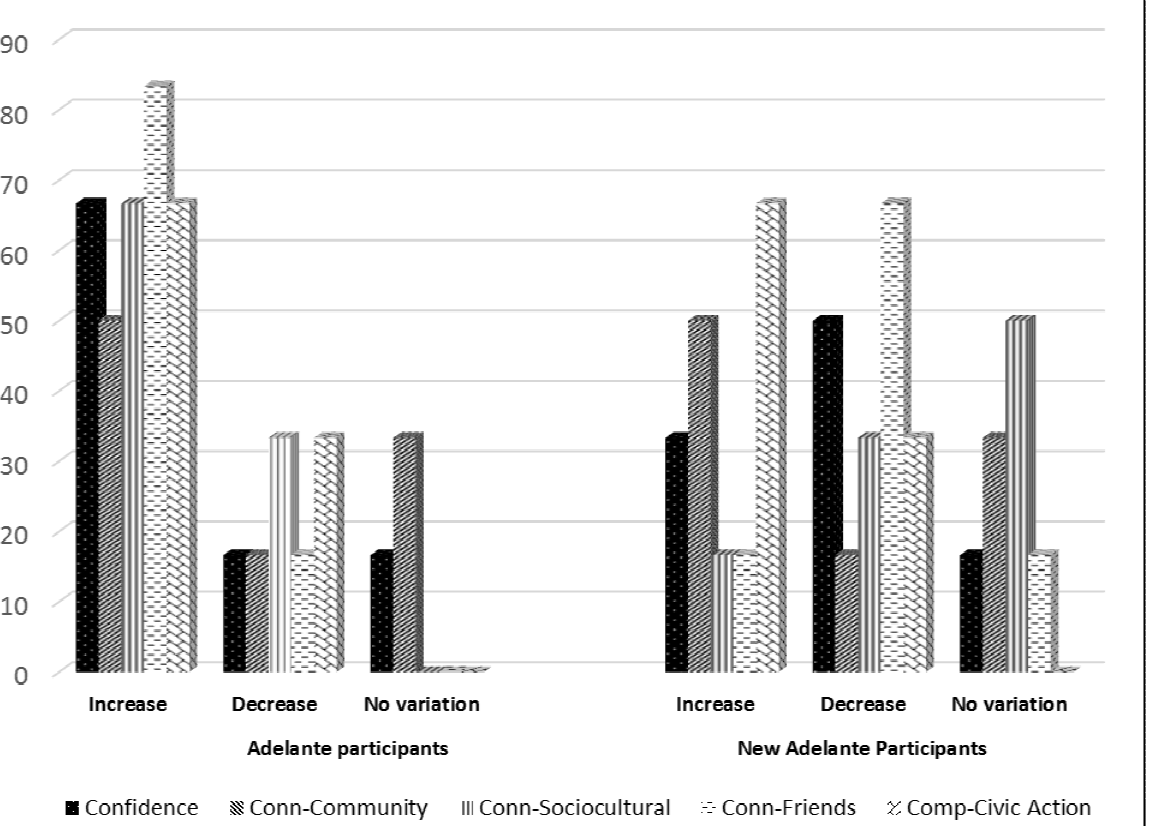
Percent of Participants with Variation in Pre/Post PYD Assets by Adelante